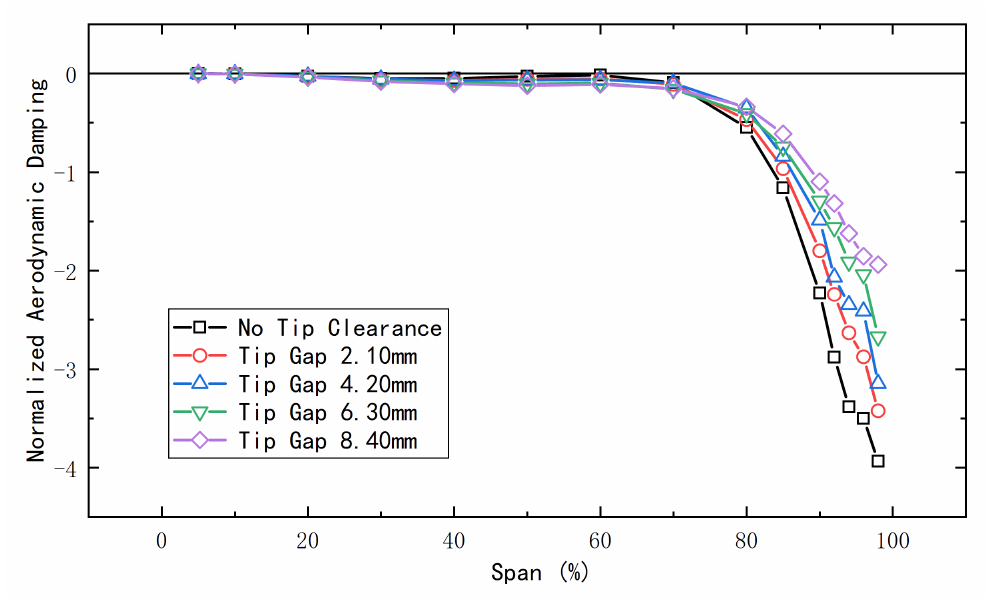
Figure 9. Aerodynamic damping versus span with various tip gap heights when IBPA = −